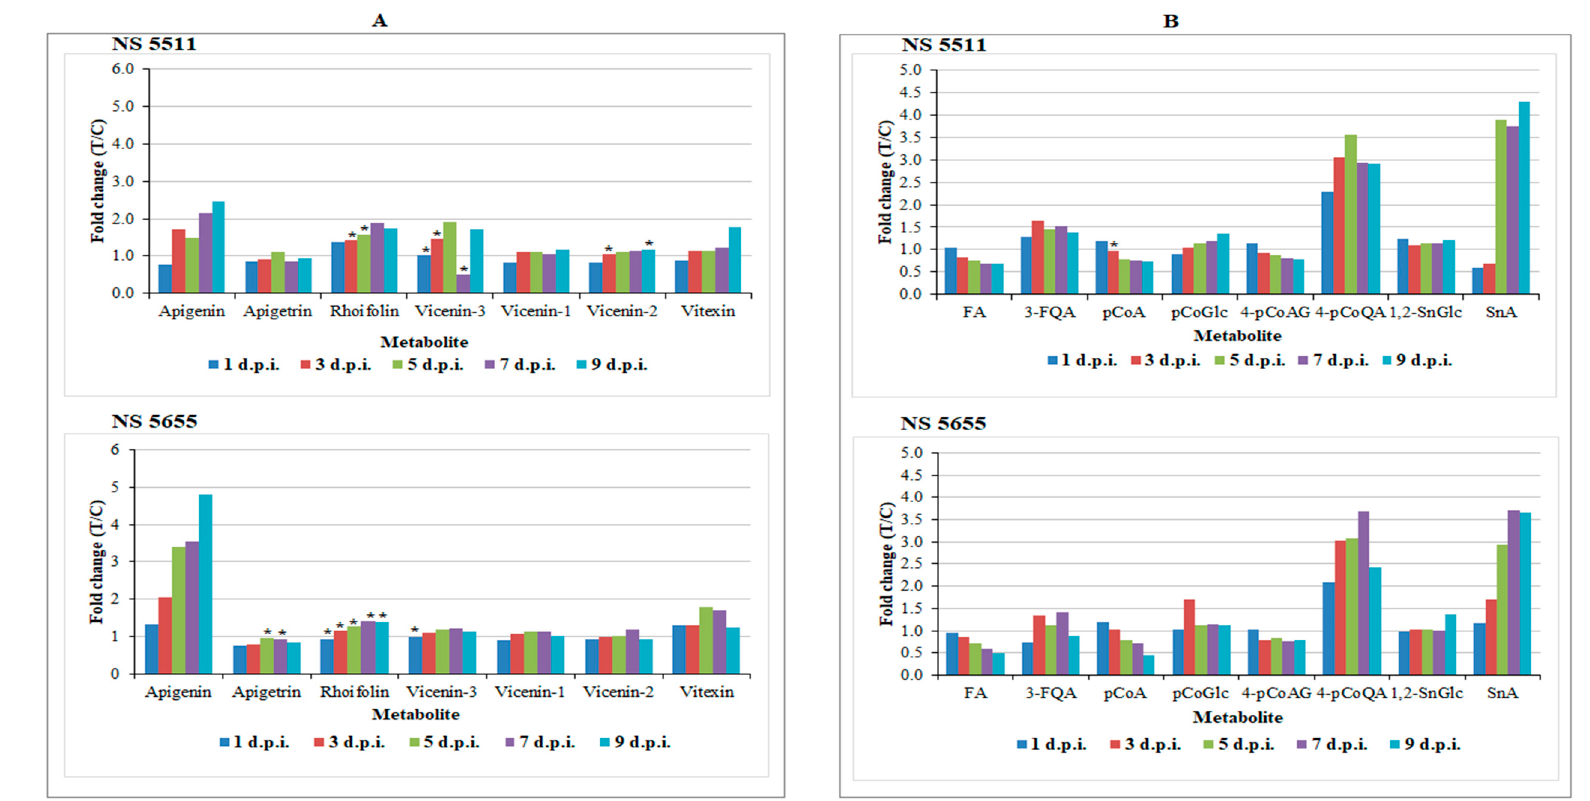
Figure 6. Relative quantification of some flavonoids ( A ) and hydroxycinnamic acids ( B ) annotated in sorghum leaves responding to infection by B. andropogonis . The relative levels of each metabolite are expressed as fold changes, computed from treated against control (T/C) samples, where fold change > 1 represents significant accumulation in NS 5511 (BT) and NS 5655 (ST). Abbreviations: ( A ) apigetrin = apigenin 7- O -glucoside; rhoifolin = apigenin 7- O -neohesperidoside; vicenin-3 = apigenin 8-C-xyloside-6-C-glucoside; vicenin-1 = apigenin 6-C-xyloside-8-C-glucoside; vicenin-2 = apigenin-6,8-di-C-glucoside; vitexin = apigenin-8-C-glucoside. ( B ) FA = ferulic acid; 3-FQA = 3-feruloylquinic acid; p CoA = p -coumaric acid; p CoGlc = 1- O -coumaroyl-beta- D -glucose; 4- p CoAg = 4-coumaroylagmatine; 4- p CoQA = 4-coumaroylquinic acid; 1,2-SnGlc =1,2-bis- O -sinapoyl-beta- D -glucoside; SnA = sinapoyl alcohol. The fold changes of the various treatment days presented in the graphs have a p -value < 0.05, except for the ones indicated by * with p -value > 0.05 but < 0.5.